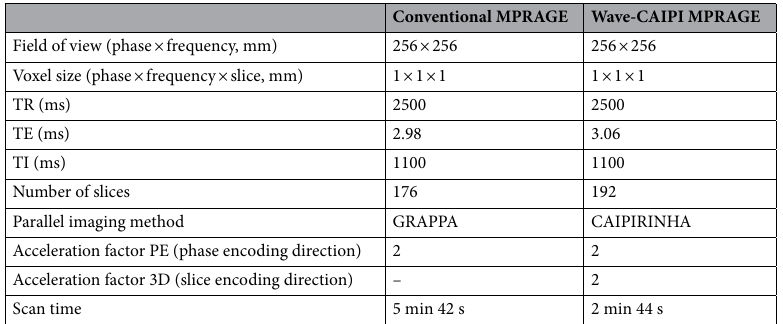
Table 1. Image parameters. CAIPIRINHA controlled aliasing in parallel imaging results in higher acceleration, GRAPPA generalized autocalibrating partially parallel acquisitions, MPRAGE magnetization-prepared rapid gradient echo, TE echo time, TI inversion time, TR repetition time, wave-CAIPI wave-controlled aliasing in parallel